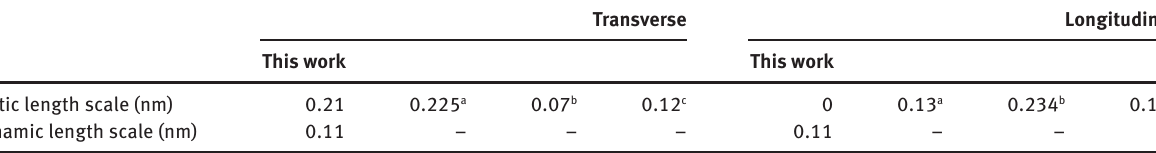
Table 1: Estimated length scales for Si.